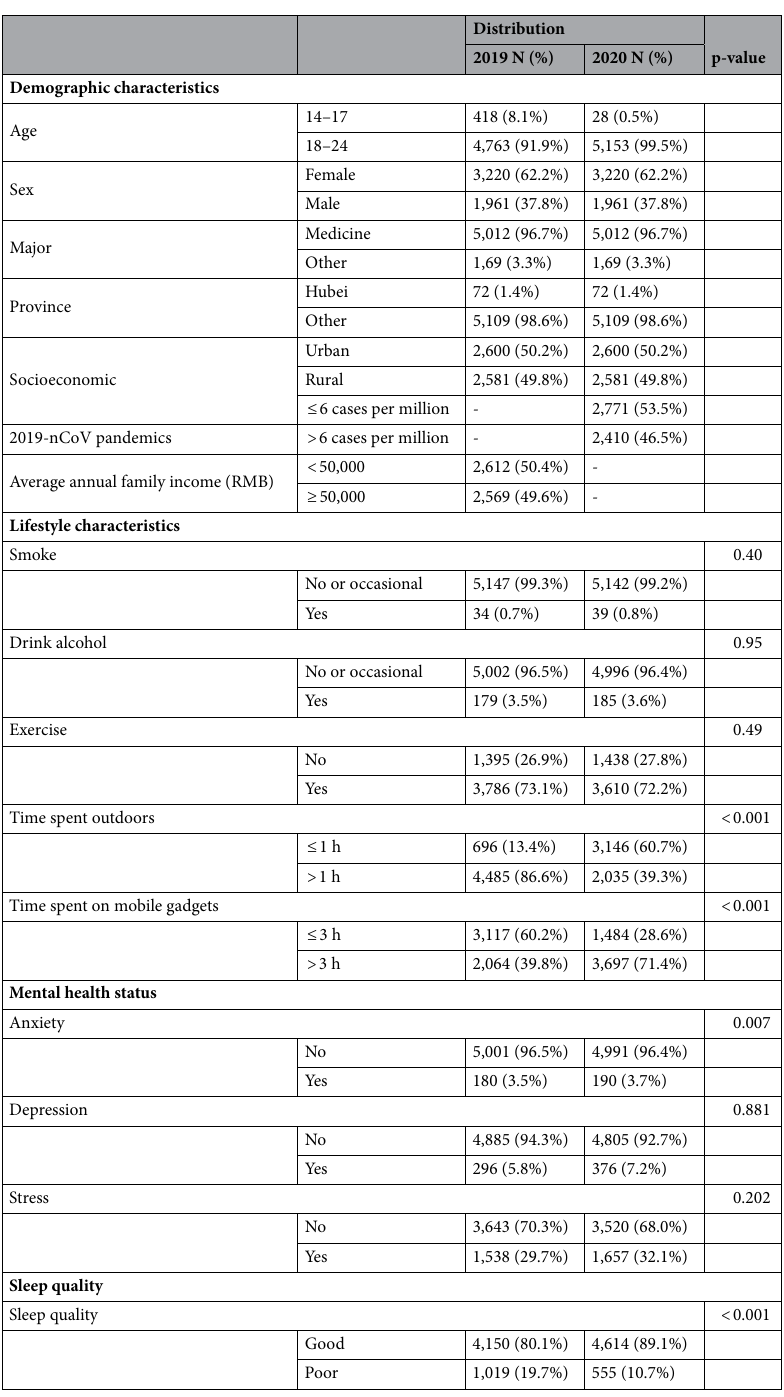
Table 1. The distribution of demographic characteristics, lifestyle characteristics, mental health status and sleep quality between 2019 and